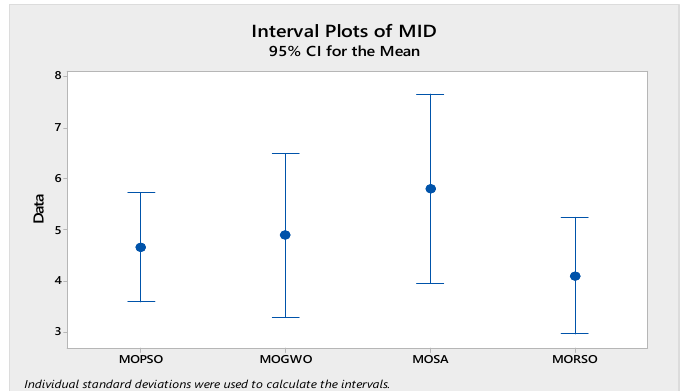
Individual standard deviations were used to calculate the intervals. Figure 20. Interval plots of MID.